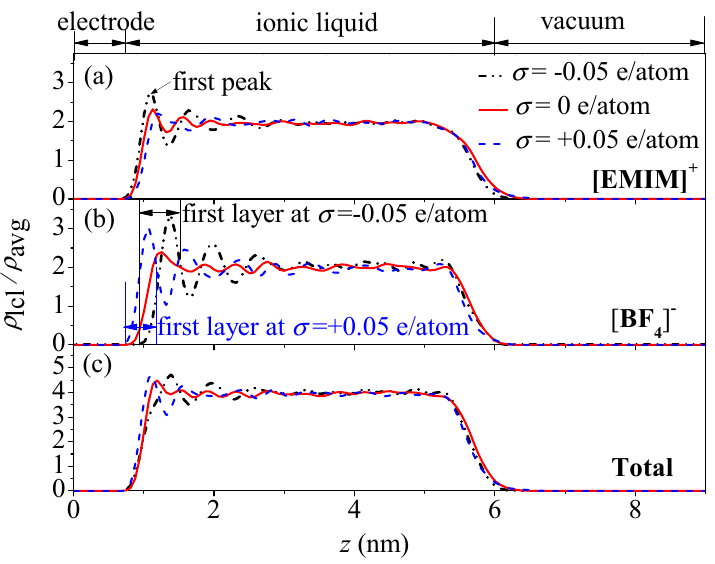
Figure 4. Concentration profiles of [EMIM] + cations and [BF 4 ] − anions near charged/uncharged non-rough electrodes: ( a ) σ = 0 e/atom, ( b ) σ = +0.05 e/atom, ( c ) σ = − 0.05 e/atom.